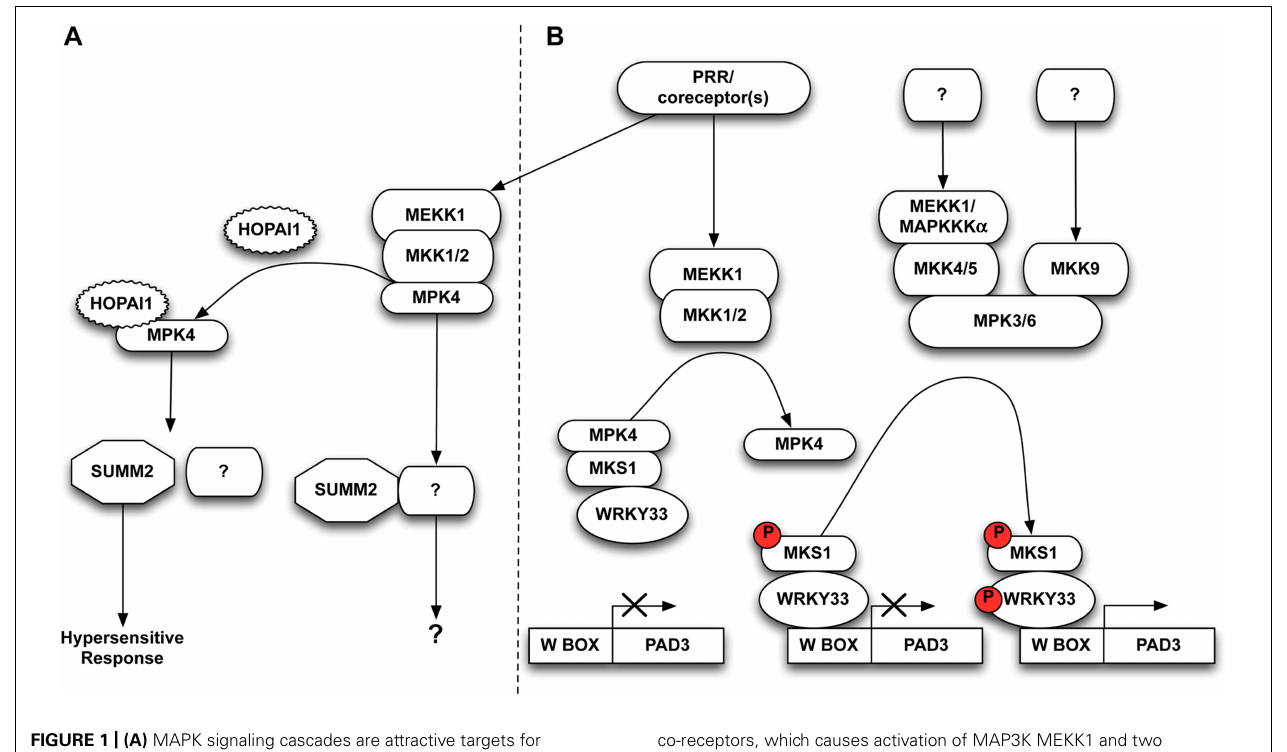
FIGURE 1 | (A) MAPK signaling cascades are attractive targets for bacterial effectors.The P. syringae HopAI1 effector irreversibly inactivates MPK4 to prevent immune responses.The R protein SUMM2 may guard processes downstream of MPK4 independent from MKS1, and triggers a hypersensitive response in the event of loss or inactivation of MPK4. (B) PAMP perception by PRRs instigates a signaling cascade, often via